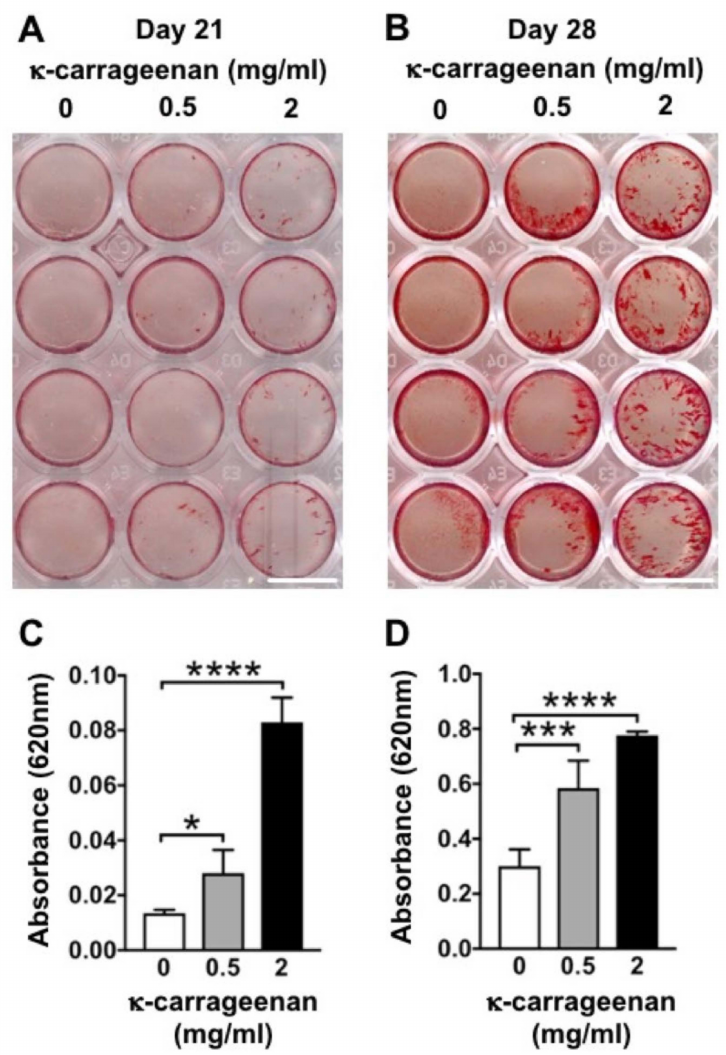
Figure 8. K-carrageenan promoted matrix mineralization in MC3T3-E1 pre-osteoblasts at day 21 and 28. ( A , B ) Alizarin red-stained mineralized matrix. ( C , D ). Quantification of alizarin red-stained mineralized matrix. Values are mean ± SD from four independent experiments. Significant effect of κ -carrageenan, * p < 0.05, *** p < 0.001, **** p < 0.0001. Bar: 1